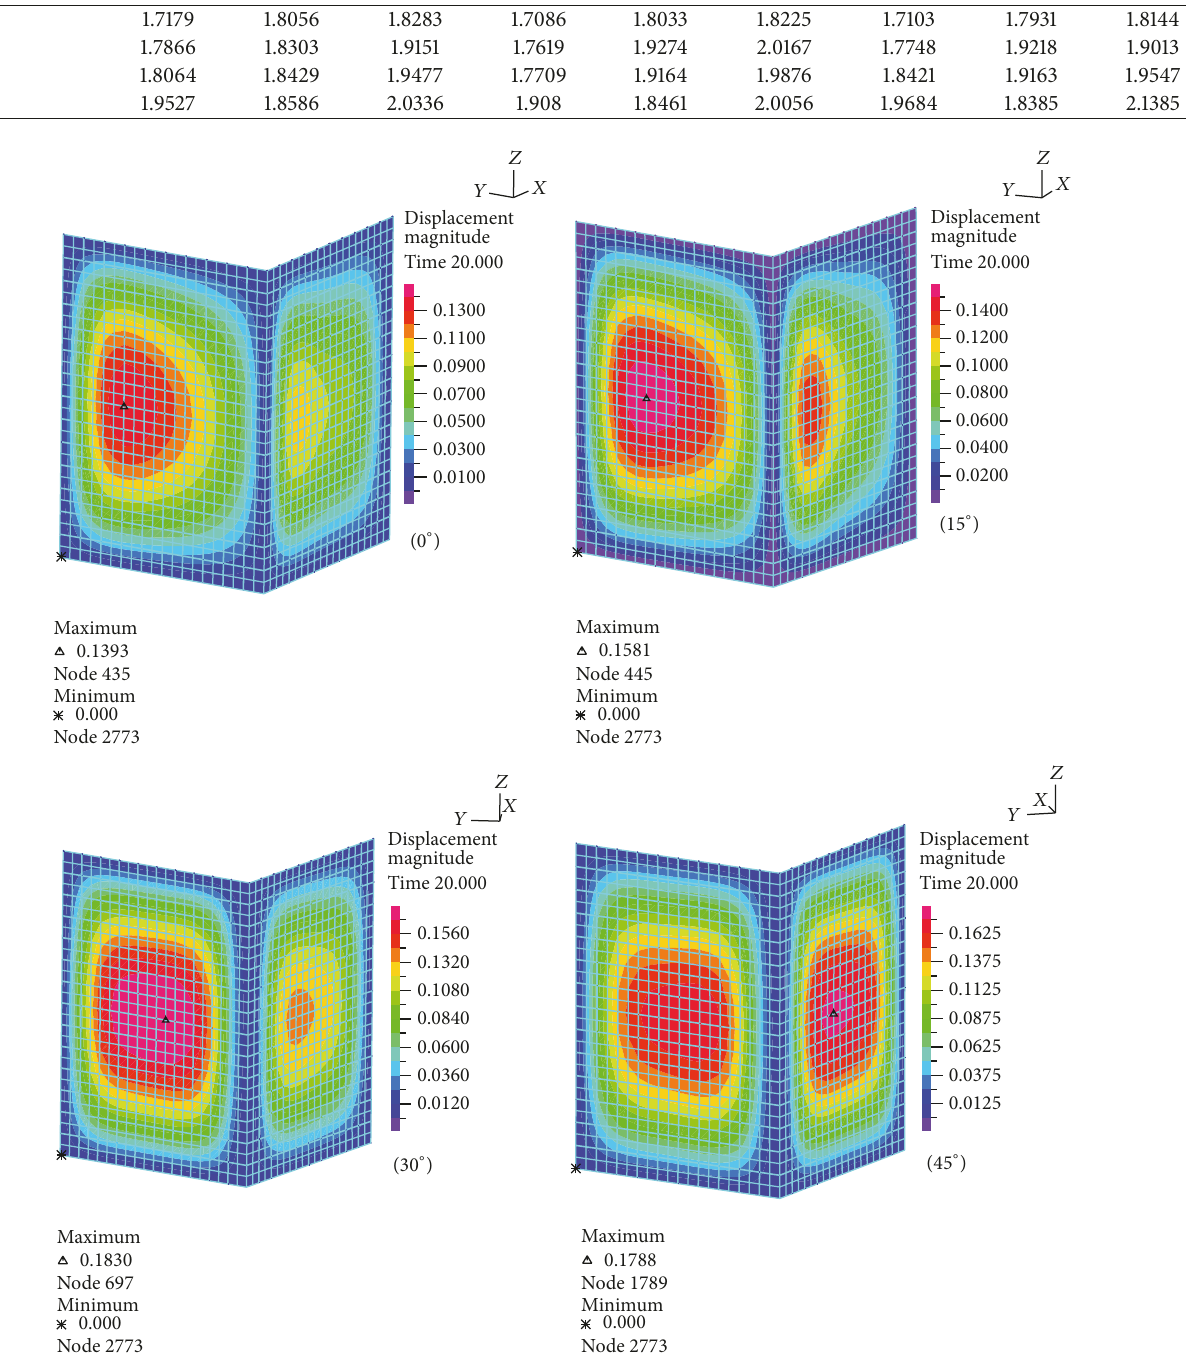
Figure 9: Structural displacement at 𝑡 = 20 s under different wind